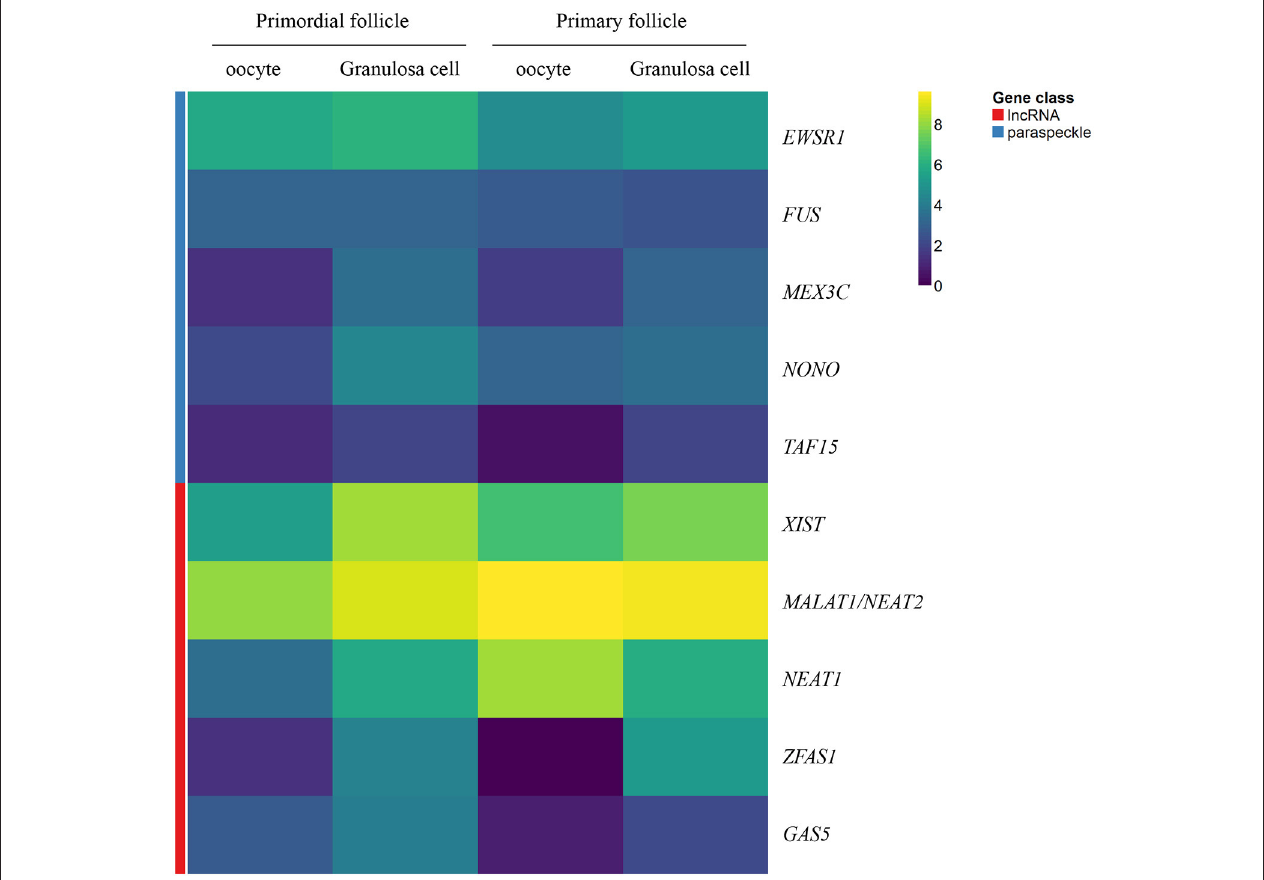
FIGURE 2 | Heatmap representation of selected genes encoding paraspeckle proteins and lncRNA genes. Heatmap of gene expression in oocytes and granulosa cells during the primordial-to-primary follicle transition. The heatmap includes the paraspeckle-encoding genes (blue bar) MEX3C, NONO , FUS , EWS, TAF15 transcripts, and the lncRNAs (red bar) NEAT1 , MALAT1 ( NEAT2 ), XIST , ZFAS1 , GAS5 . Color code reflects average FPKM